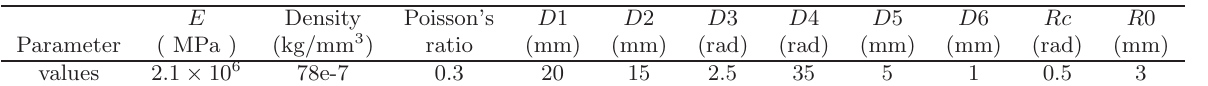
Fig. 5. (a) Geometrical models of the structure. (b), (c), (d) Different optima when safety factors 1.5, 1.2 and 1.1, respectively. Table 1. Initial values